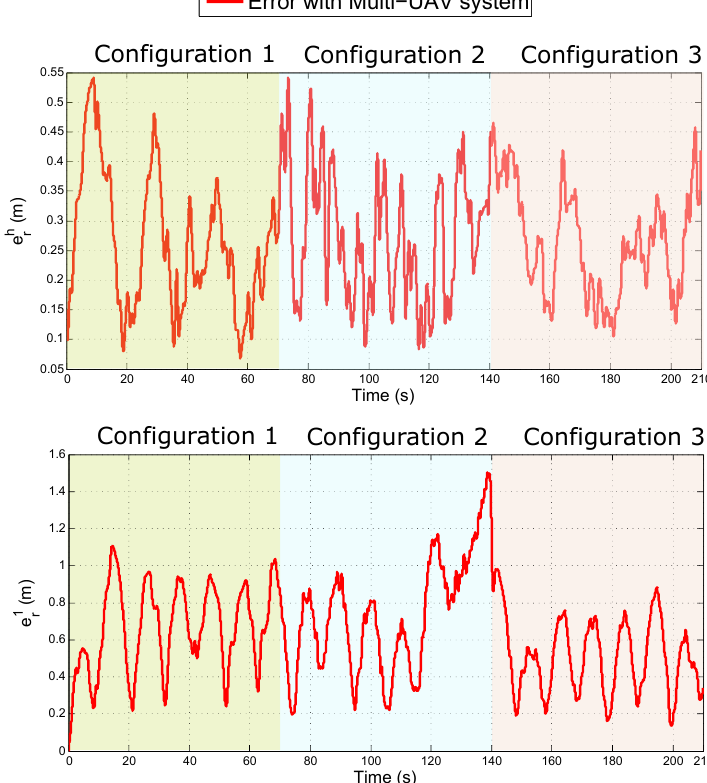
Figure 15. Comparison of the quality of the estimated position of the lead agent ( upper plot ) and the Quad 1 ( bottom plot ) in